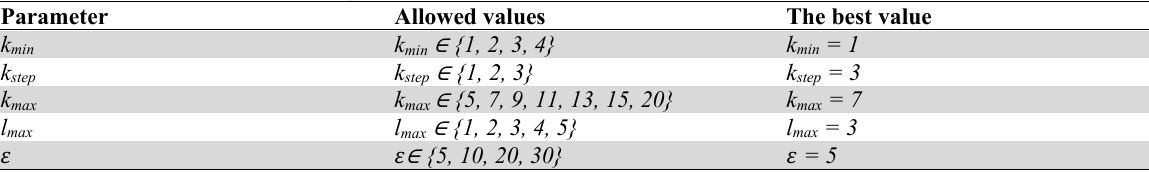
The best-found values of each GVNS